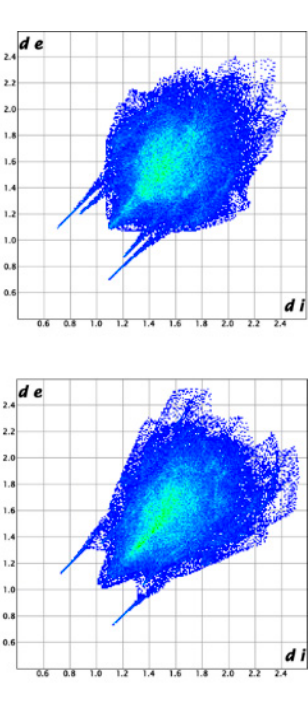
Figure 9. Fingerprint plots of the BE_IV (top) and BE_I (bottom).